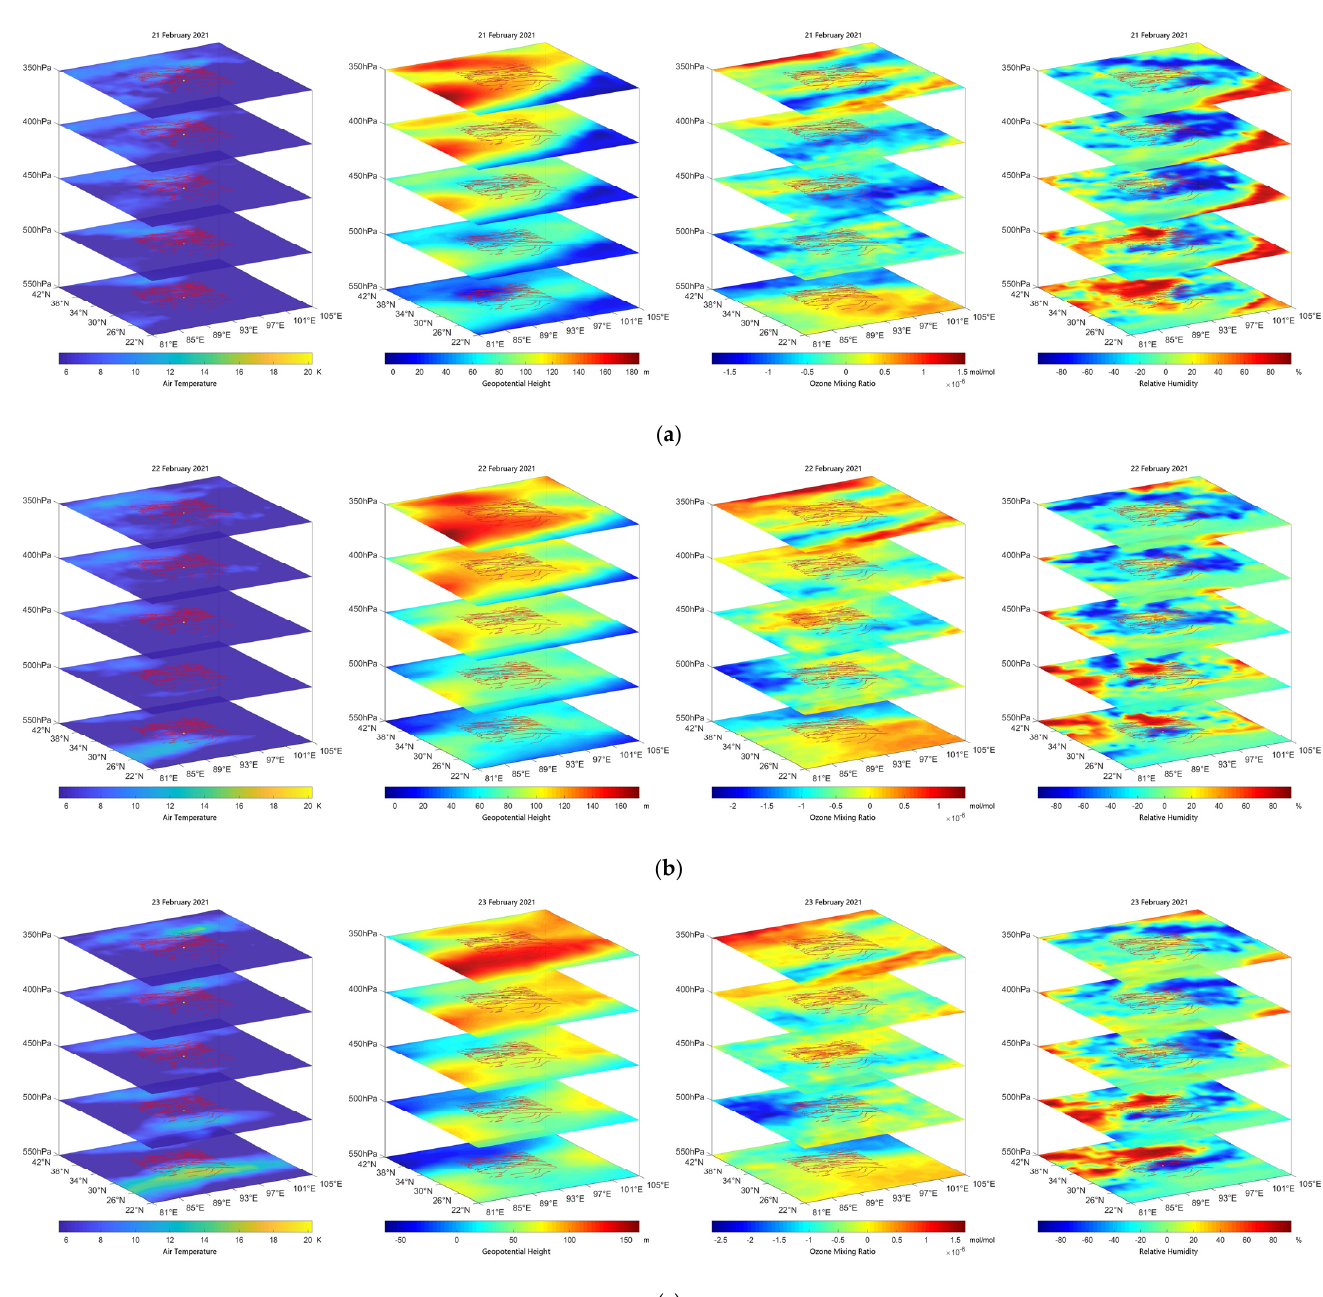
Figure A1. Composite atmospheric anomaly maps during atmospheric thermal anomalies associated with earthquake in Yangbi on ( a ) 7 April; ( b ) 8 April; ( c ) 9 April; ( d ) 10 April; ( e ) 11 April; ( f ) 12 April; ( g ) 13 April; ( h ) 14 April; ( i ) 15 April; ( j ) 16 April; ( k ) 17 April; ( l ) 18 April; ( m ) 19 April; ( n ) 20 April; ( o ) 21 April, 2021. The epicenter and faults are shown by yellow point and red lines, respectively. For each row, the subplots represent air temperature, geopotential height, ozone mixing ratio and relative humidity from left to right.